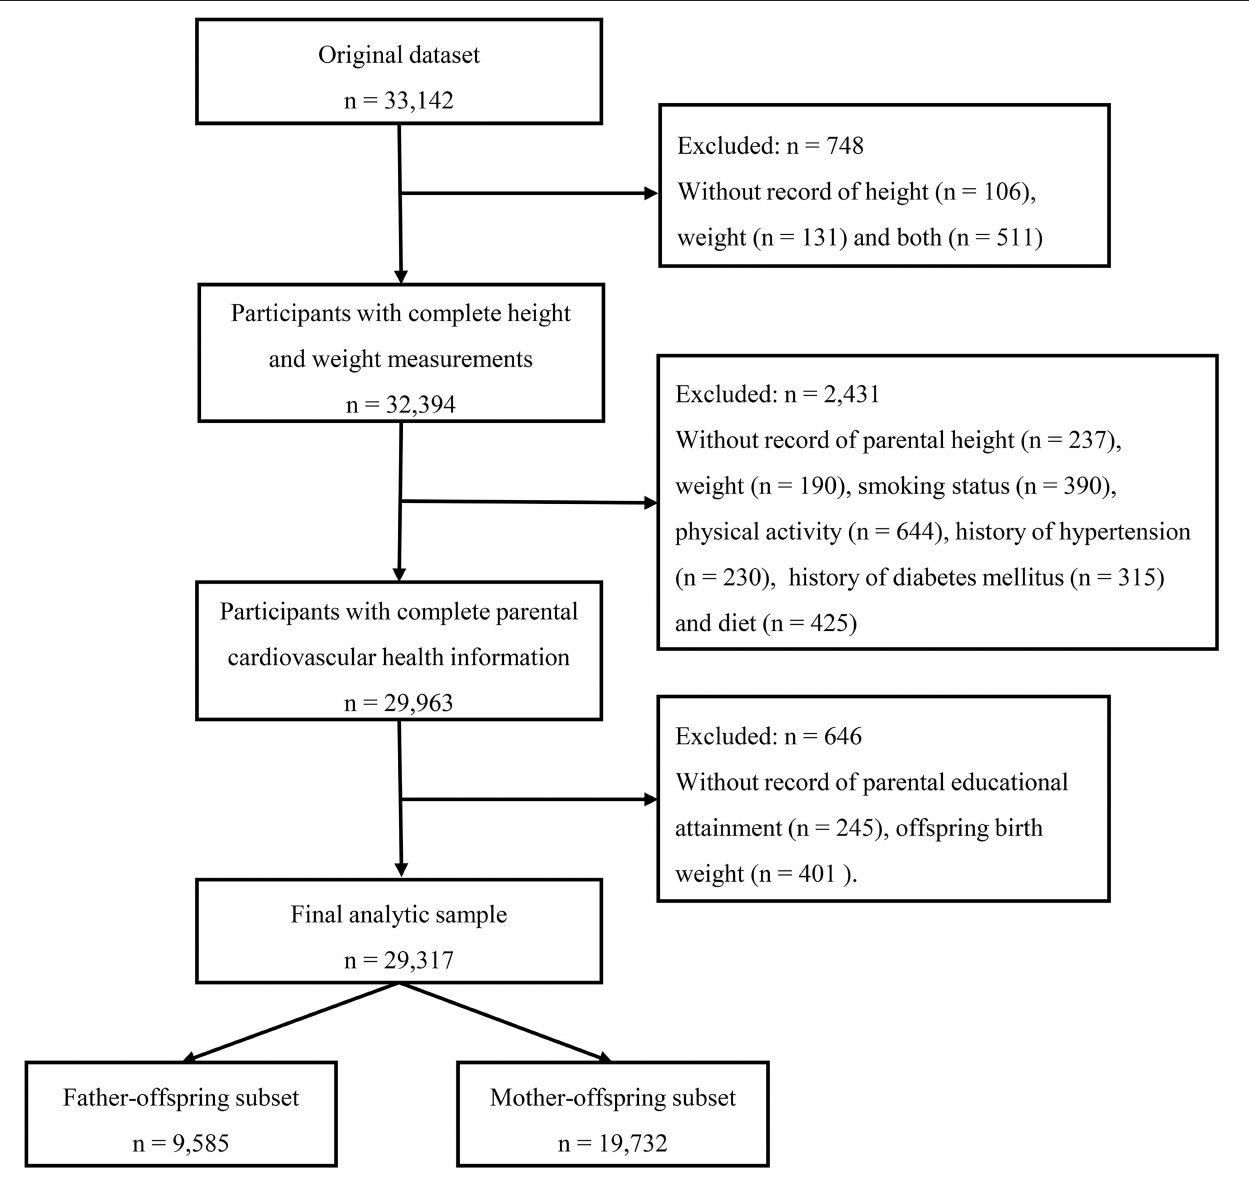
FIGURE 1 | The selection process and flow chart of study